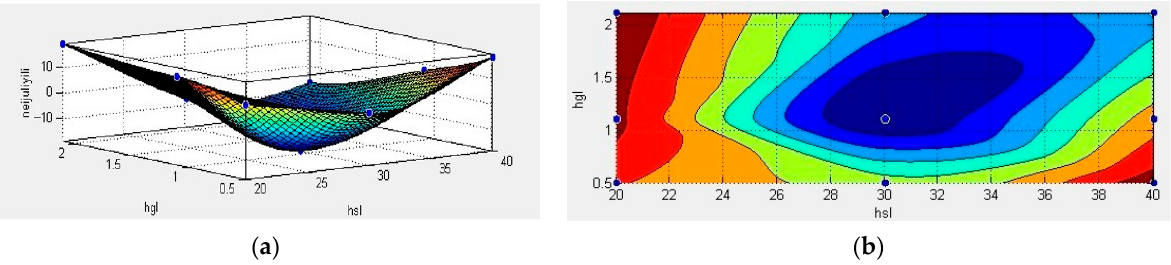
Figure 7. Relationship between cohesion, root content, and water content. Note: ( a ) is a three- dimensional surface between the three and ( b ) is an equivalent curve.